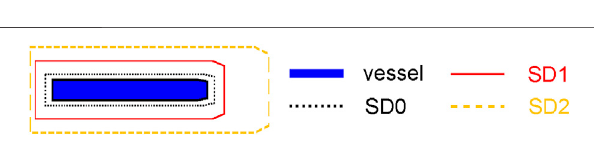
FIGURE 6 | Example con fi guration of vessel ship domains.